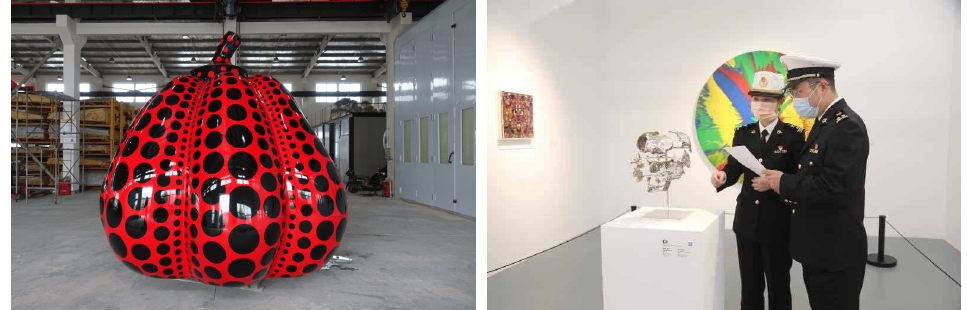
Figure 6. The customs transaction was managed and completed within 24 h for Yayoi Kusama’s Pumpkin to arrive at the fourth China International Import Expo, Shanghai. Image courtesy: Shanghai Customs.